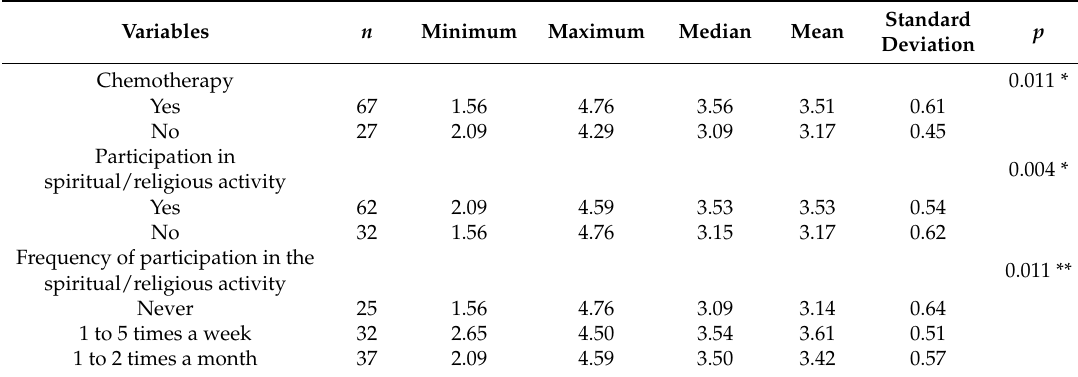
Table 3. Distribution of the participants of a rehabilitation center for mastectomized women, according to the comparison of the values of PSRC scores with the statistically significant variables. Ribeir ã o Preto, SP, Brazil, 2013–2014 ( n =